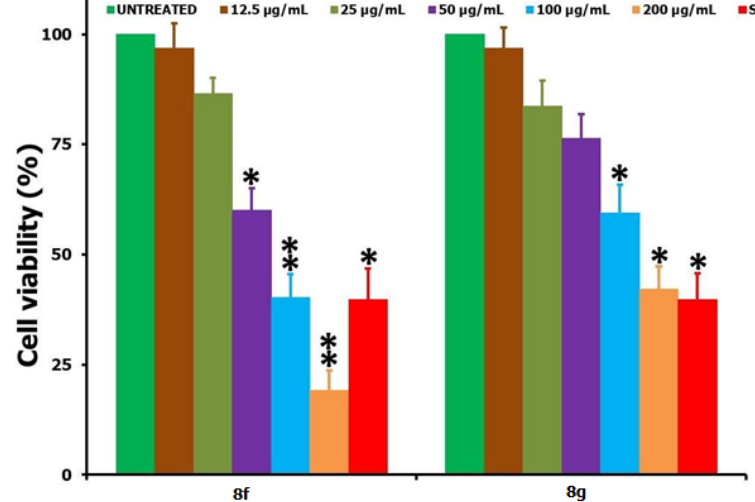
Figure 4. Comparison of MTT assay results of L929 noncancer cells following the incubation of two compounds 8f and 8g with a range of concentrations (12.5–200 μ g/mL) over a 48 h period. STD stands for melphalan of 15 μ g/mL; * and ** refer to the significant ( p < 0.05) and highly significant ( p < 0.01) values as compared to those obtained with the untreated controls.